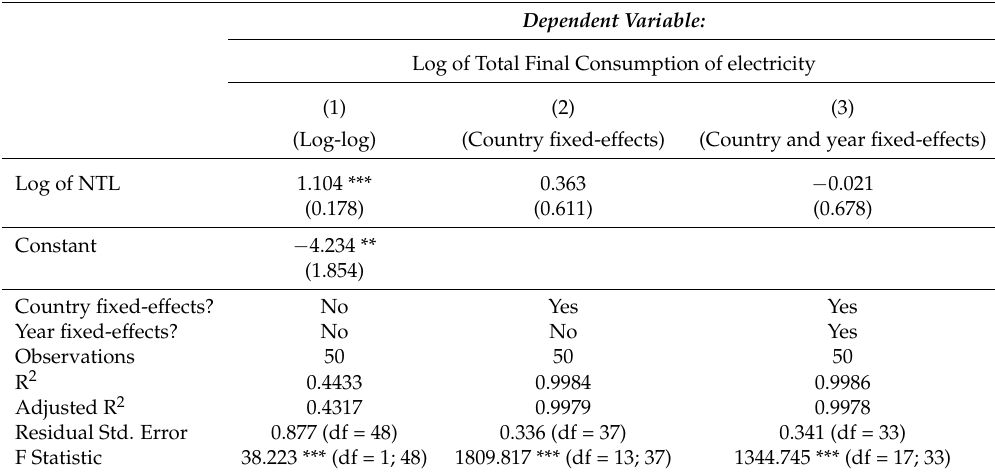
Table A1. Regression for COMMPUB—Low-income